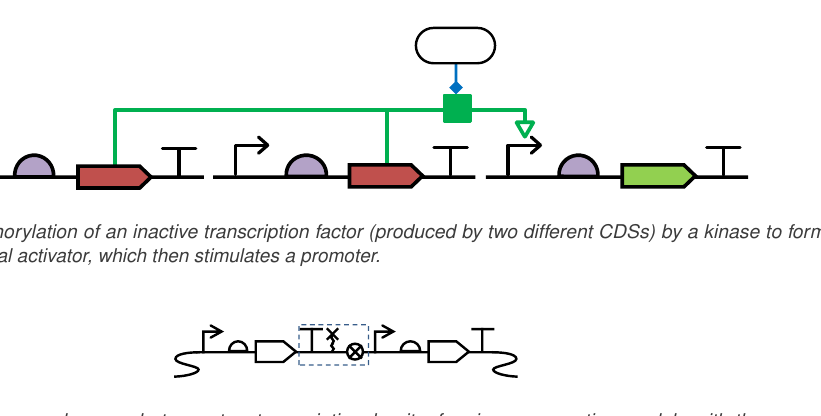
Figure 42: Ribozyme and spacer between two transcriptional units, forming a separation module with the preceding terminator (dashed box), with the whole construct integrated into the